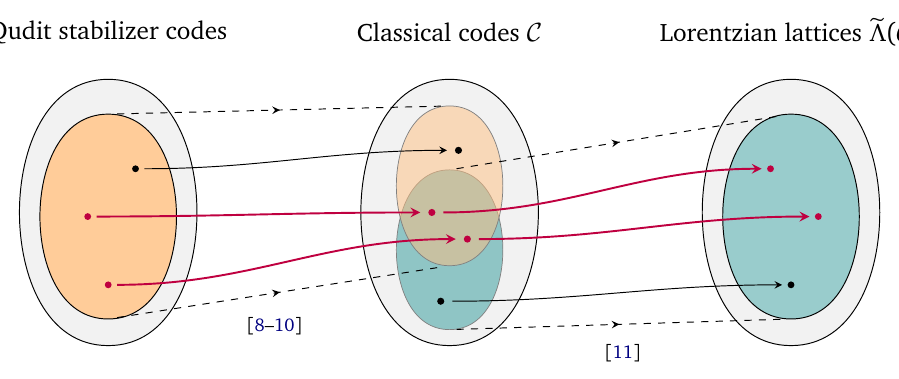
Figure 1: An illustration of our construction of Lorentzian lattices from qudit sta- bilizer codes. There is a class of classical codes associated with qudit stabilizer codes [ 8–10 ] (the light orange region in the middle ellipse). On the other hand, Lorentzian lattices can be built out of a certain class of classical codes [ 11 ] (the light green region in the middle ellipse). Focusing on the intersection of the two classes of classical codes allows us to construct a Lorentzian lattice from a qudit stabilizer code (the red